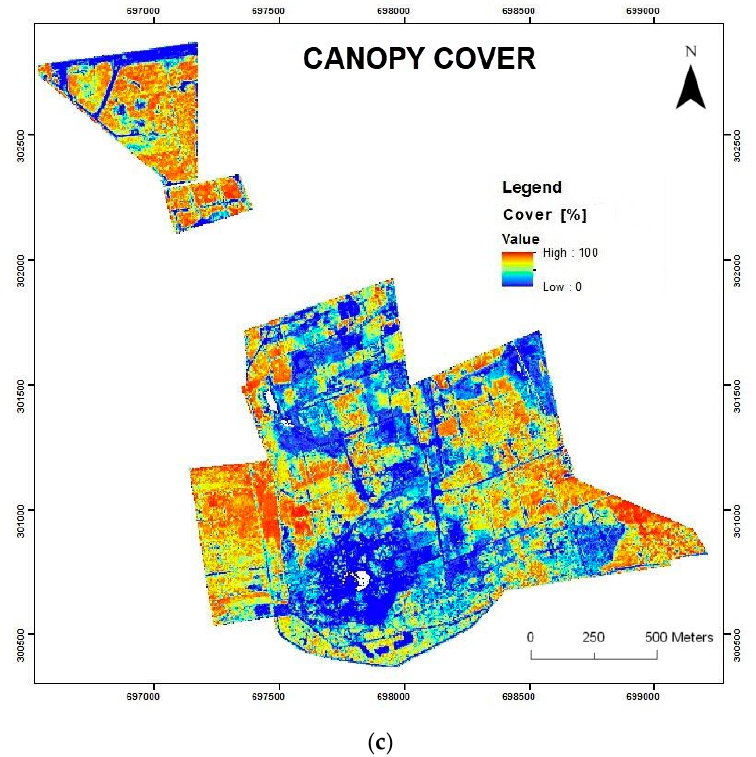
Figure 8. Vegetation parameters for the Jeziórko analysed areas (ALS, 2012): ( a ) height of vegetation (95th percentile), ( b ) standard deviation of height, and ( c ) canopy cover (value of 0%–100%).